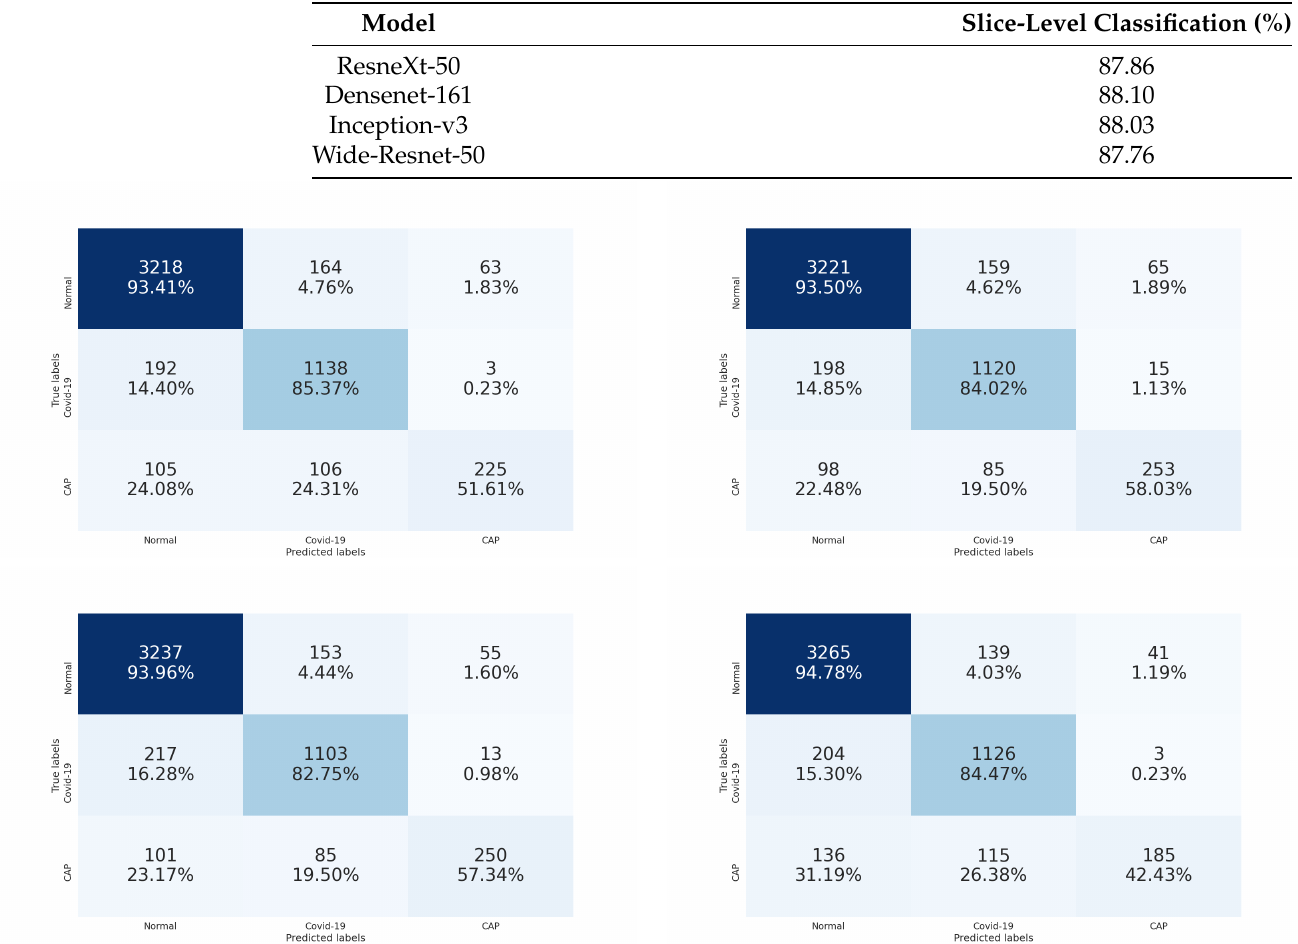
Table 2. Validation slice-level classification results using stacked grayscale image with four backbone